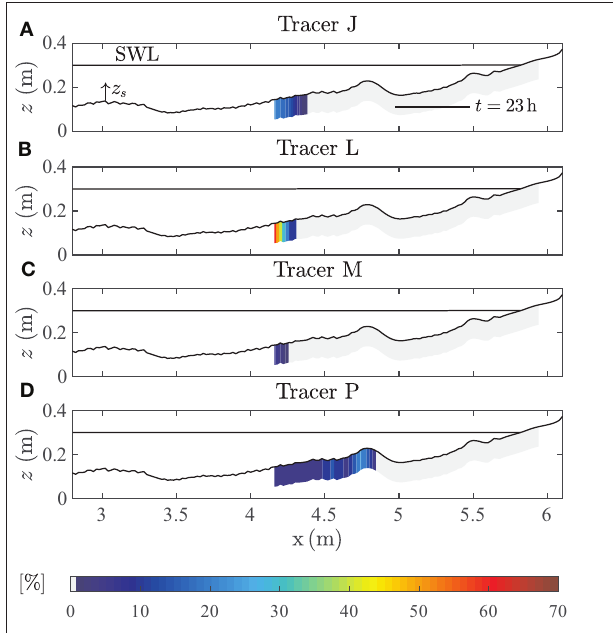
FIGURE 8 | Microplastic distribution [% of the (A) tracer “J”, (B) tracer “L”, (C) tracer “M,” and (D) tracer “P” ( D n > 1 mm )] below the beach profile surface.